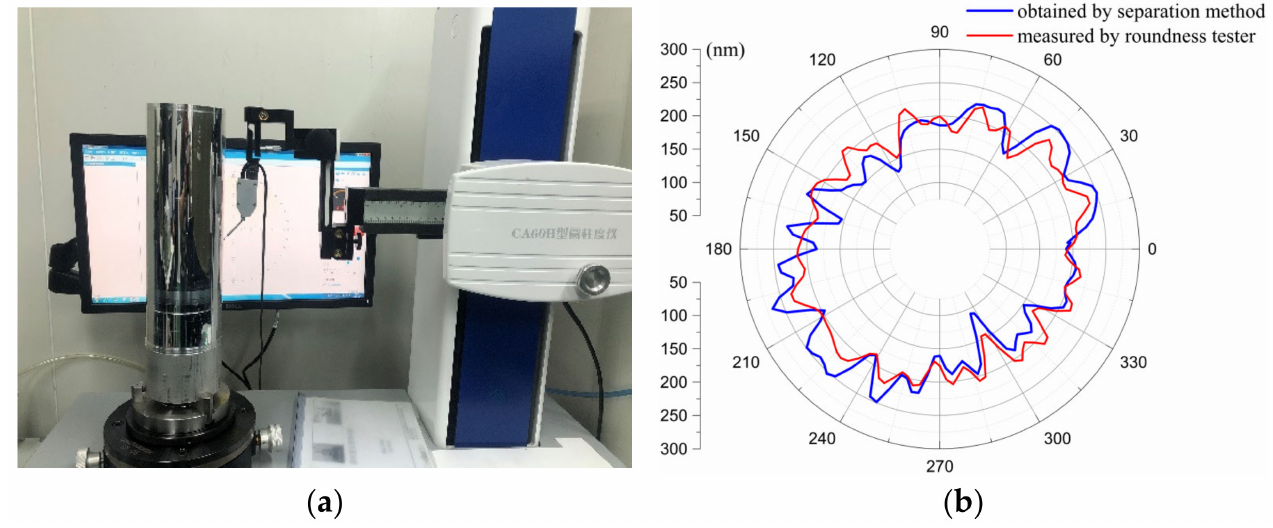
Figure 18. WRE of the mandrel tested by the in situ separation method and roundness tester: ( a ) WRE tested by a roundness tester, ( b ) WRE measured by various